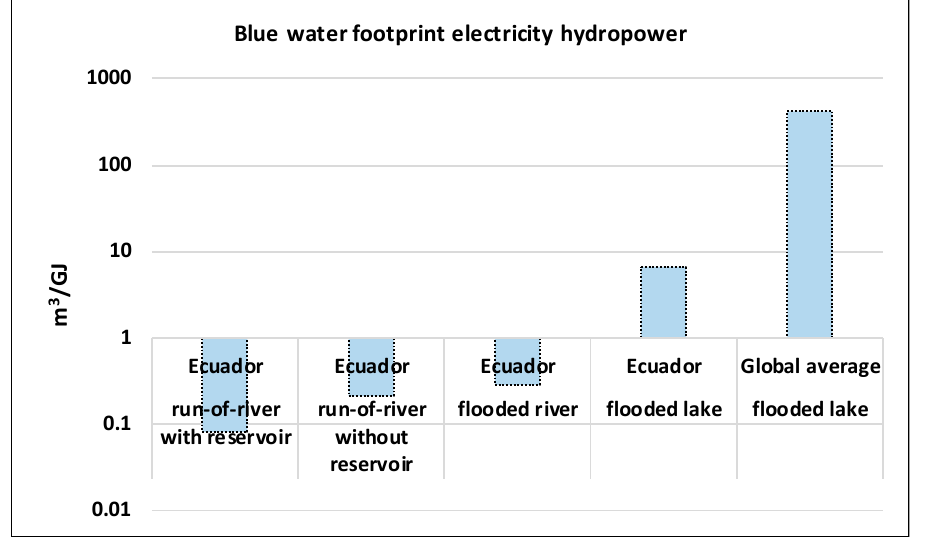
Figure 6. Blue water footprints of hydropower for four hydropower types in Ecuador and the global average (source: Vaca-Jimenez et al. [5]; Mekonnen and Hoekstra [40]).